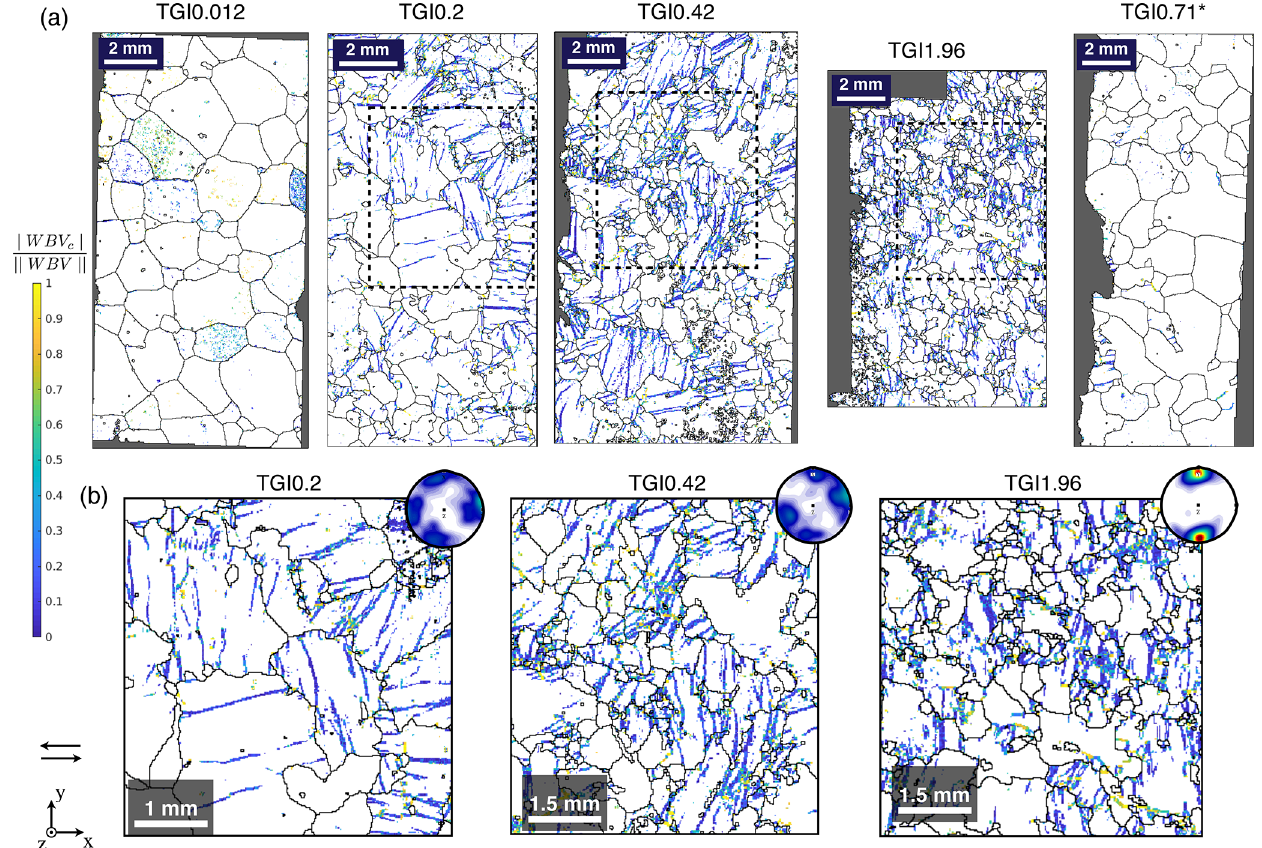
Figure 5. Maps of the norm of the weighted Burgers vector, || WBV || . (a) Map examples for every shear strain. Zoomed in region in (b) delimited by black dashed rectangles. (b) Details on the TGI0.2, TGI0.42 and TGI1.96. Grains boundaries ( > 5 ◦ ) are reported as black lines. Non-indexed regions reported in grey. Pole figures representing c axis orientations are reported at the top right.